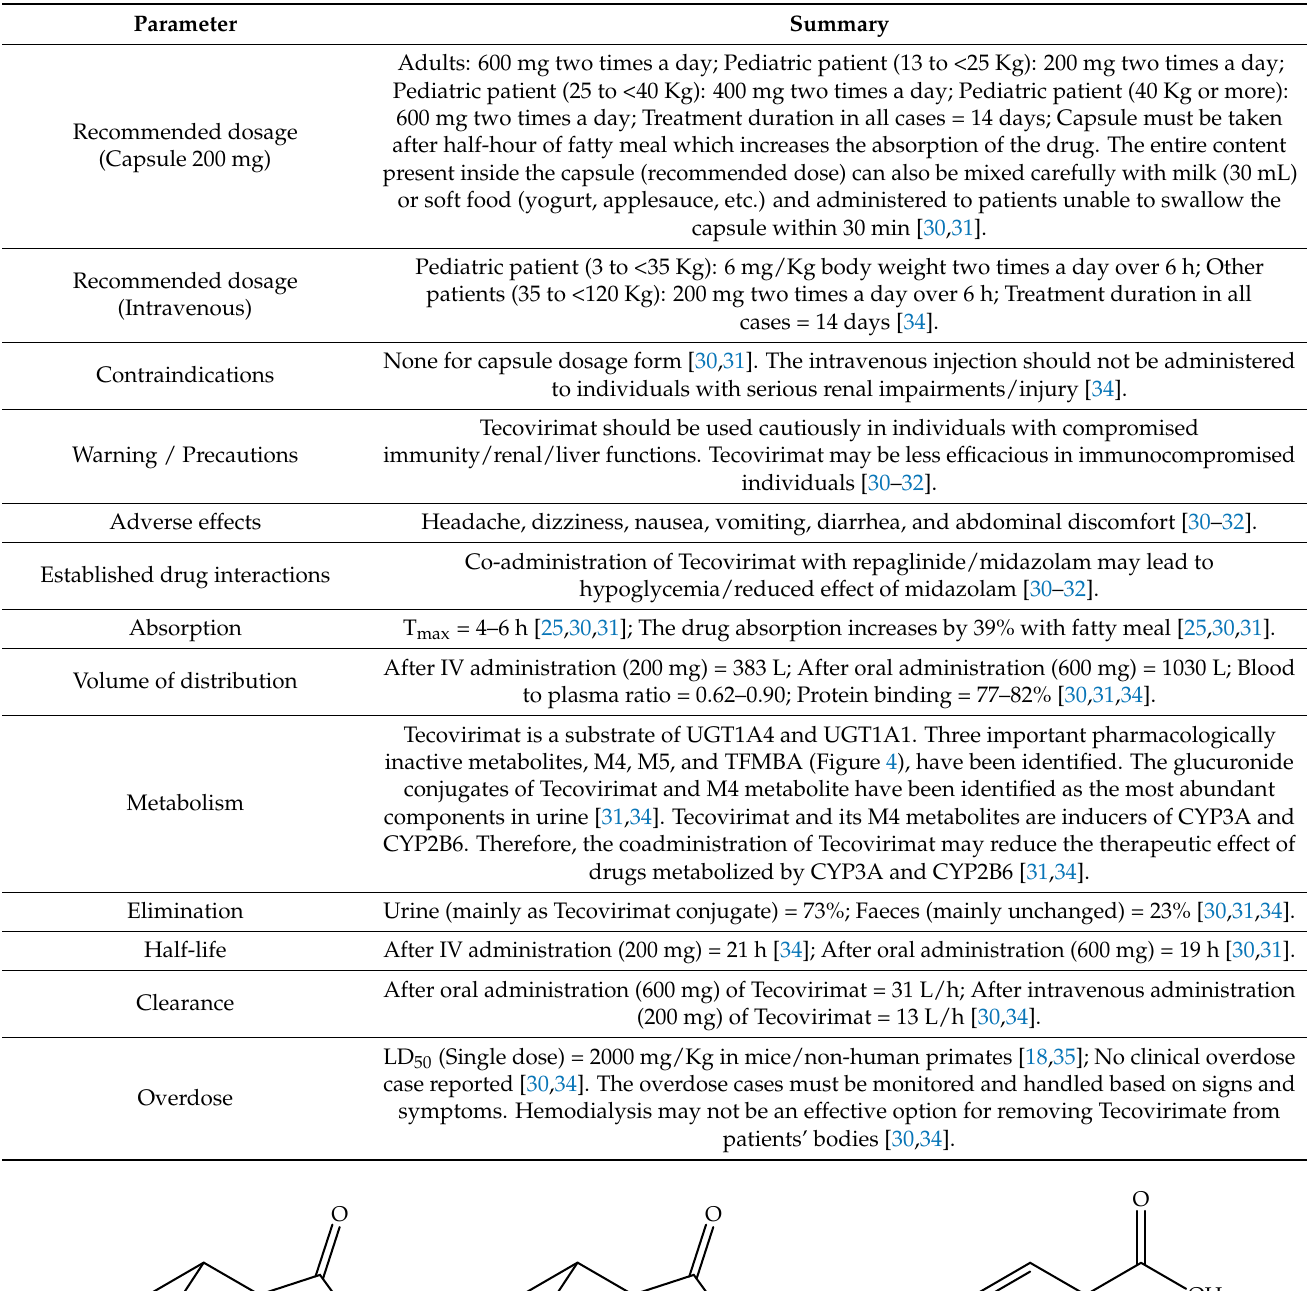
Table 2. Important pharmacological parameters of Tecovirimat.